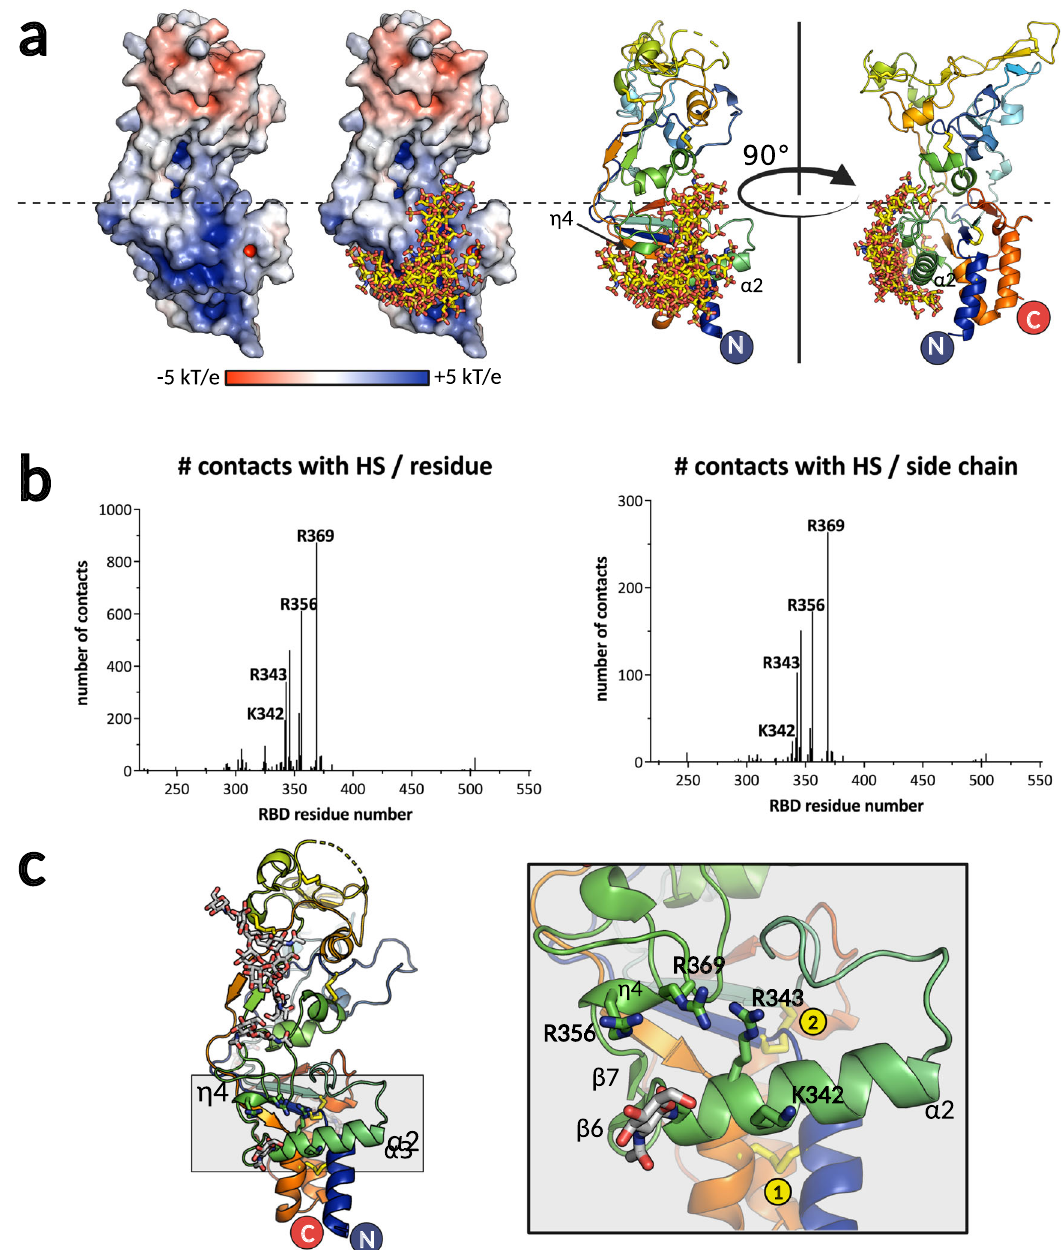
Fig.5|PredictionofHS-bindingresiduesanddesignofthevariantsimpairedin binding. a Electrostatic potential distribution was calculated using Adaptive Poisson-BoltzmannSolvermodule 67 inPymol 65 andplottedonthesolventexcluded surface of the RBD, with red corresponding to the negative, and blue to positive potentials (two left panels). The ensemble of HS molecules modeled by ClusPro 31 maptothelowersubdomainandaredisplayedinsticksonthetworightpanels.The RBDisshown in cartoon modeland in two orientations to illustrate the location of predicted HS-binding secondary structure elements. b Predicted number of